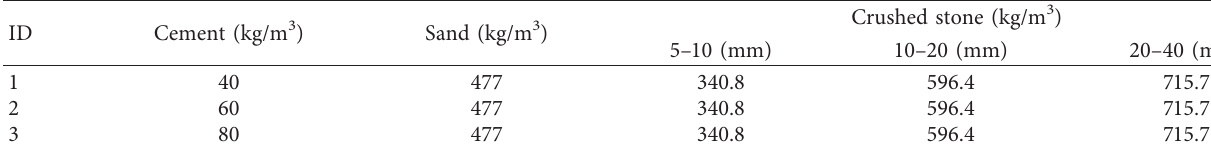
Table 1: Details of the test specimens.